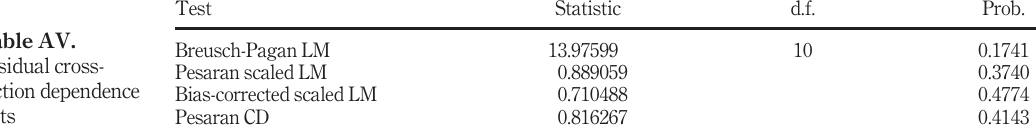
Table AV. Residual cross- section